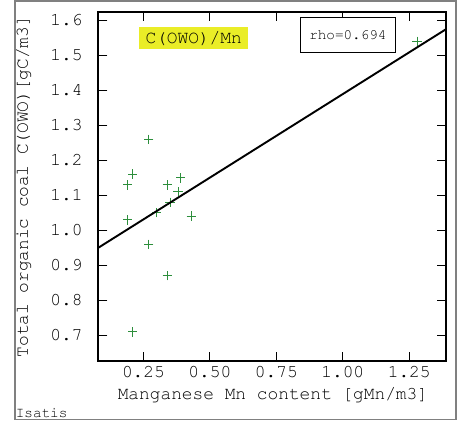
Fig. 15. Diagram correlation of phosphate ion in underground water, with the marked regression line Y / X in the area of water intake in the region of Kłodzko (14 wells)